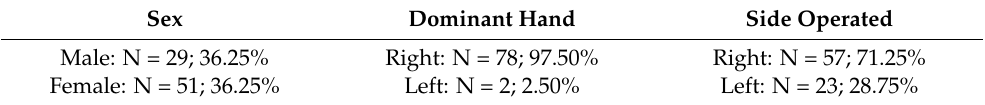
Mean age = 57.92 years. Standard deviation = 10.52 years. Table 2. Sex, dominant hand, and side operated.